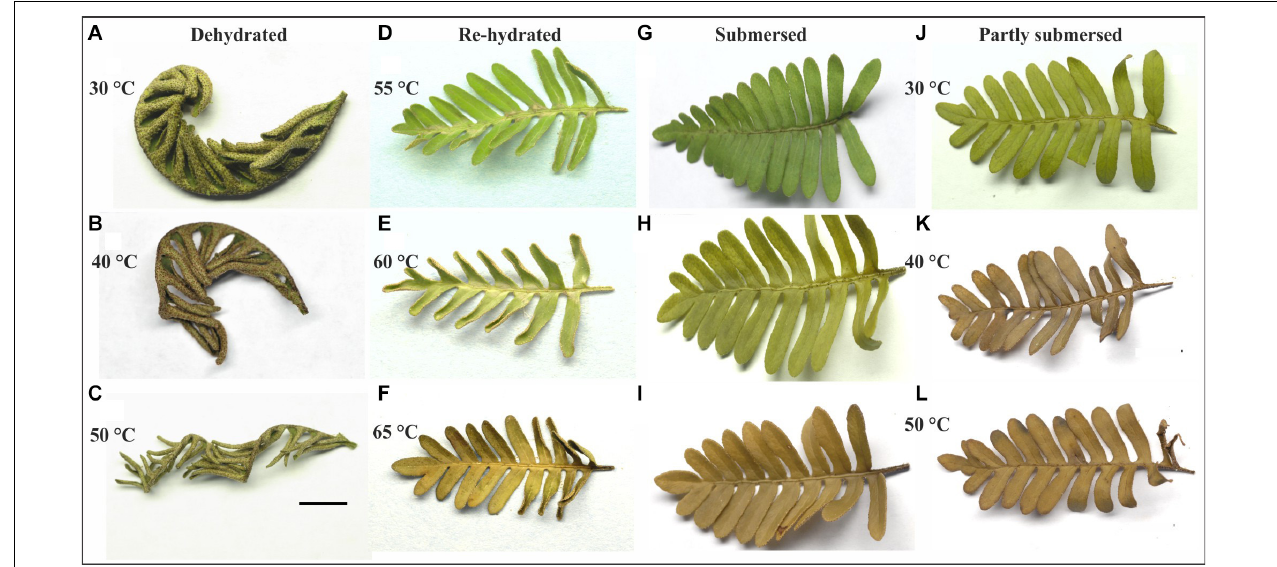
FIGURE 2 | Response of dehydrated (A,B,C) , submersed (G,H,I) , and partly submersed (J,K,L) fronds to 24 h heating at 30, 40, and 50 ◦ C, and fronds re-hydrated after exposure to 55, 60, and 65 ◦ C (D,E,F) . Exposure to ≥ 40 ◦ C resulted in tight curling of dehydrated fronds and browning of the hydrated fronds. Re-hydrated fronds show discoloration near the rachis between 55 and 60 ◦ C and complete discoloration of the frond after 65 ◦ C. Scale bar = 1